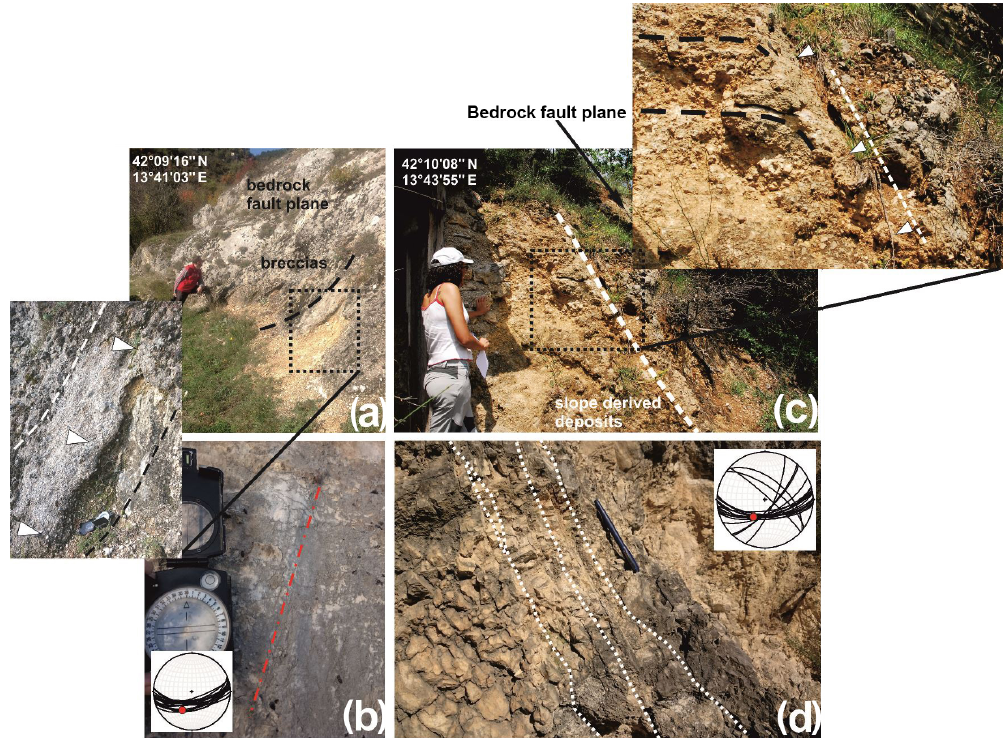
Figure 5. (a) Early Pleistocene breccias dragged along a secondary fault splay parallel to the Avezzano–Bussi fault (see Fig. 2 for location); a detail in inset, where white triangles indicate a fault plane affecting the breccias and dashed lines mark the dragging of the deposits. (b) Bedrock fault plane along which the breccias are dragged; slickenlines, red dashed line. on the Schmidt net diagram (inset), the synthetic shear planes detected in the fault zone (black great circles) and the pitch of the slickenlines, derived from statistical analysis of seven measurements (red dots) are plotted. (c) Middle Pleistocene slope deposits affected by extensional faults (white dashed line) parallel to the Avezzano–Bussi fault (see Fig. 2 for location); a detail in inset, where black dashed lines mark the attitude of the deposits in the fault zone, and the white dashed line and triangles mark a fault plane affecting the deposits. (d) Shear zone related to the fault plane in (c) ; white dotted lines, synthetic shear planes; the synthetic shear planes detected in the fault zone (black great circles) and the pitch of the slickenlines (red dots) are plotted on the Schmidt net diagram